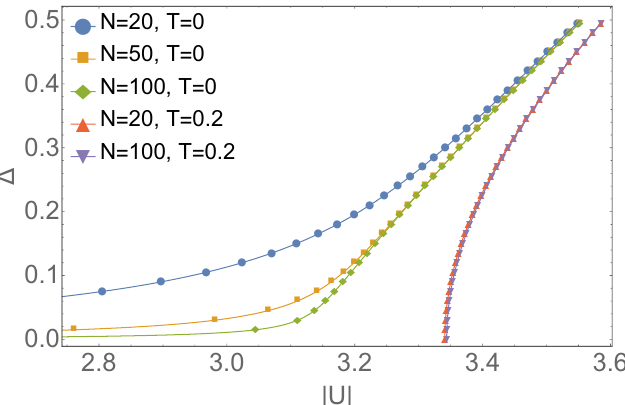
Figure 7: (color online) The meanfield pairing function ∆ for a Dirac Hamilto- nian (35) on a torus as a function of the interaction strength | U | for different system sizes N and temperatures T . We consider here a square lattice on a torus of lengths N × N . The numerical results are in agreement with (79). For T ≈ 0 and N = 20 the critical interaction is zero, but already for N = 100 the pairing ∆ ( U ) approaches the thermodynamic limit. For T = 0.2 the finite size correction in (79) is negligible, the two curves for N = 20 and N = 100